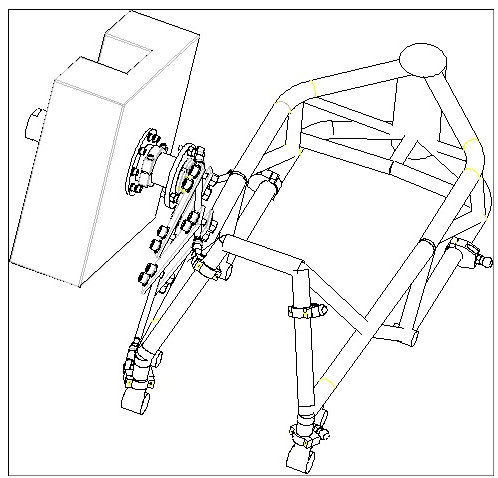
Figure 5. Three conrods connect the bike main frame to the pivot on each side, providing an isostatic restraint. The centre of gravity of the bike is aligned with the pivot.